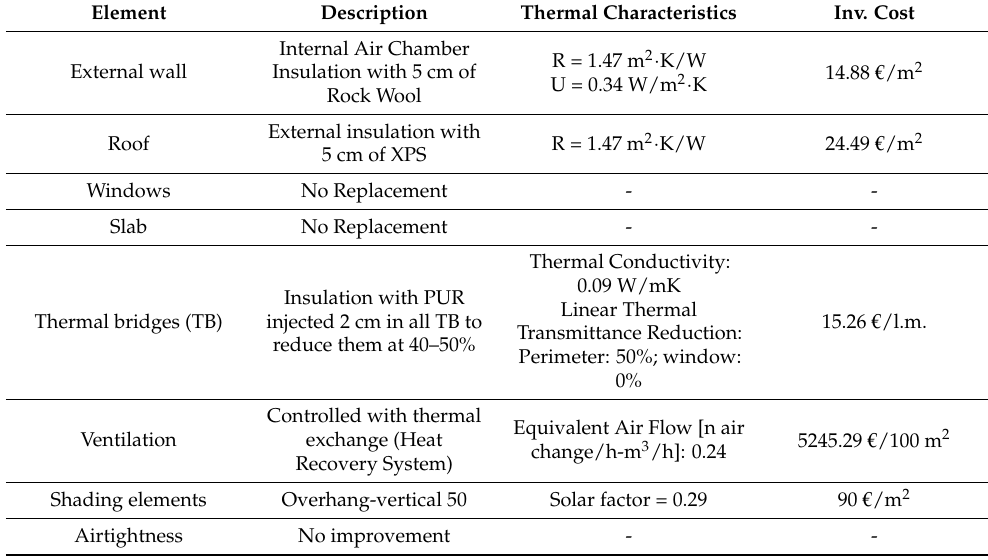
Table A13. POS14: Renovation measures of solution 8; and POS14s: Renovation measures of solution